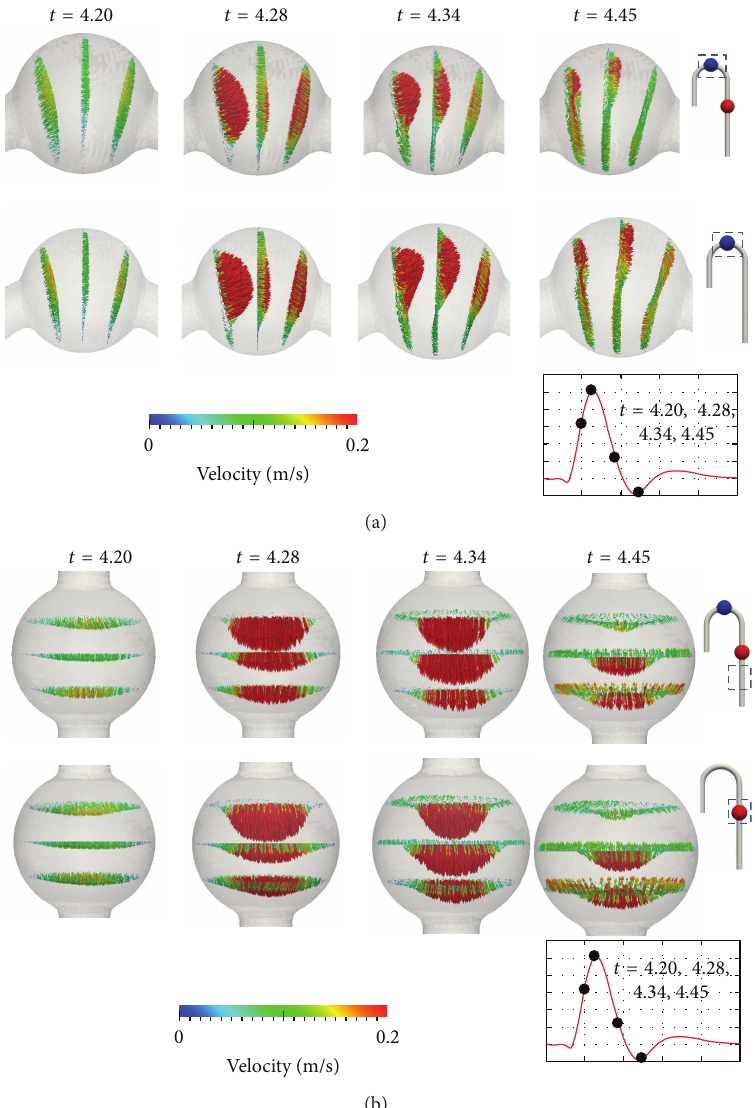
Figure 5: Velocity vector in aneurysms: (a) TAA in DAA model versus TAA in AAA cured model, (b) AAA in DAA model versus TAA cured